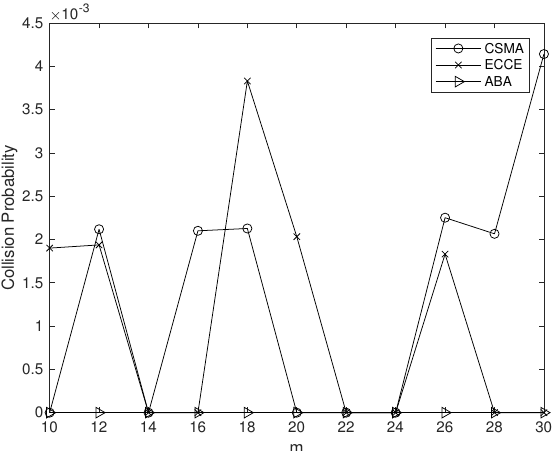
Figure 9. Collision probability vs. m